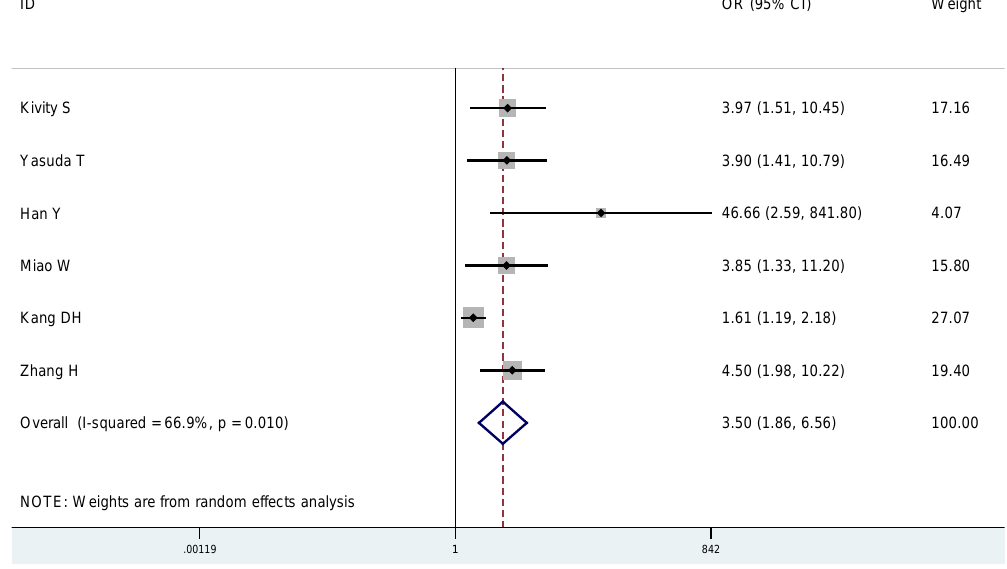
NOTE: Weights are from random